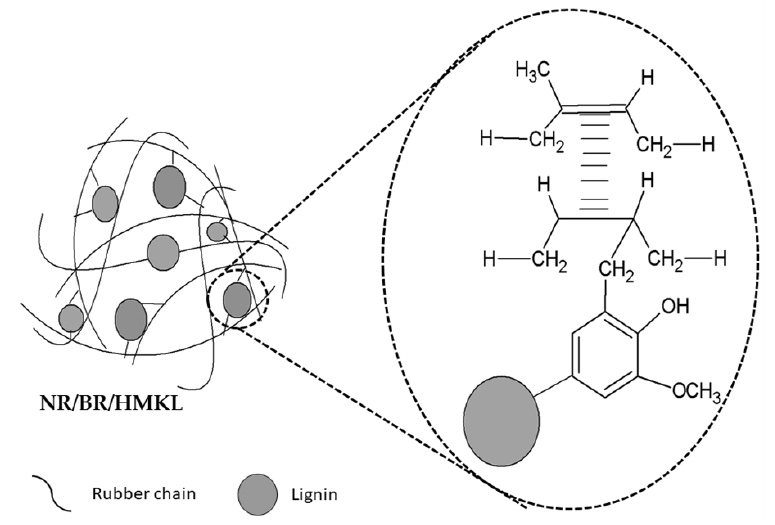
Figure 8. Schematic illustration of the proposed reinforcing mechanism of HMKL on NR/BR.